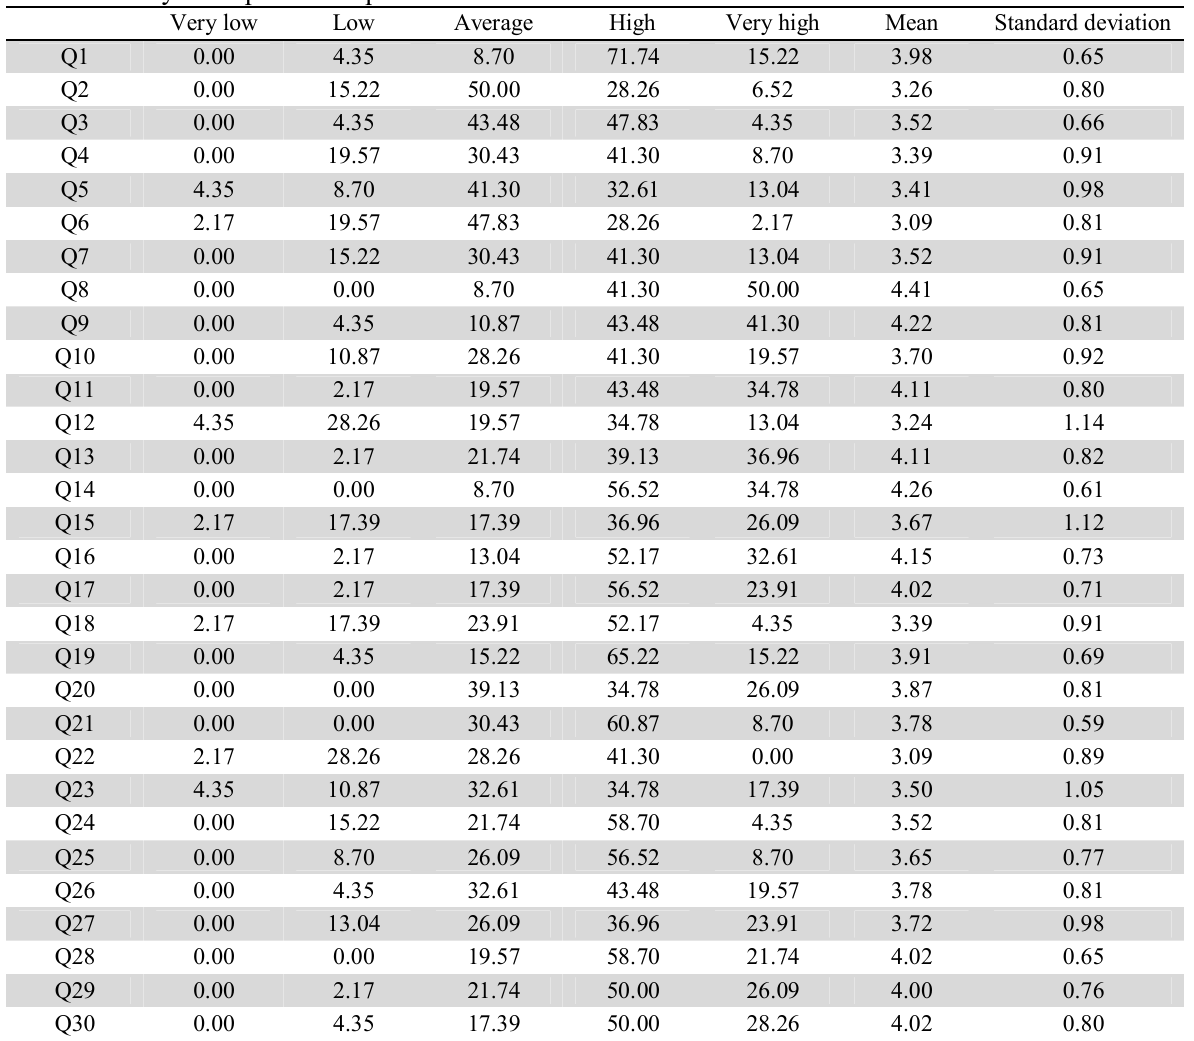
The summary of responses to